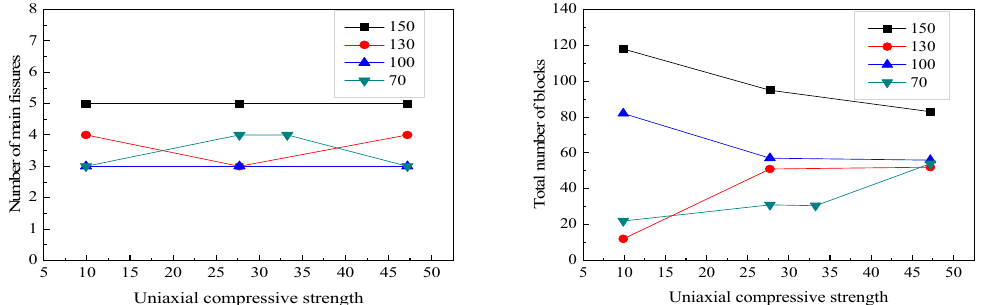
Figure 11. Relationship between uniaxial compressive strength and blasting effectiveness.